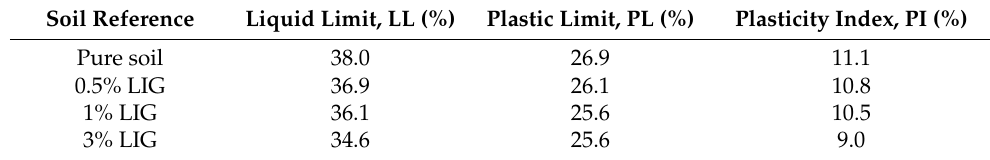
Table 1. Results of Atterberg limits tests.